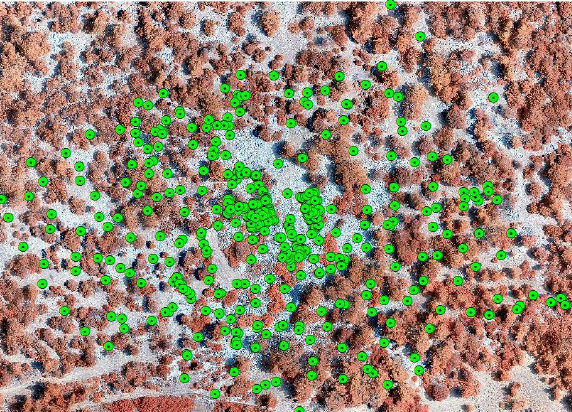
Figure 6: Kimisala site near infrared orthophotomosaic, with reference points